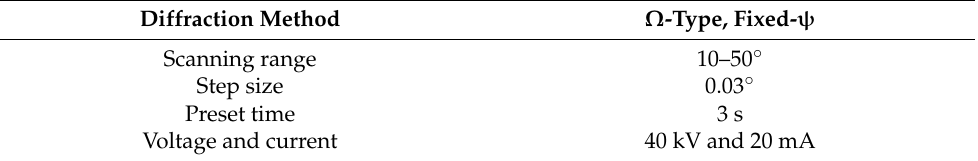
Table 8. XRD conditions for thickness measurement of nickel-plating layer.